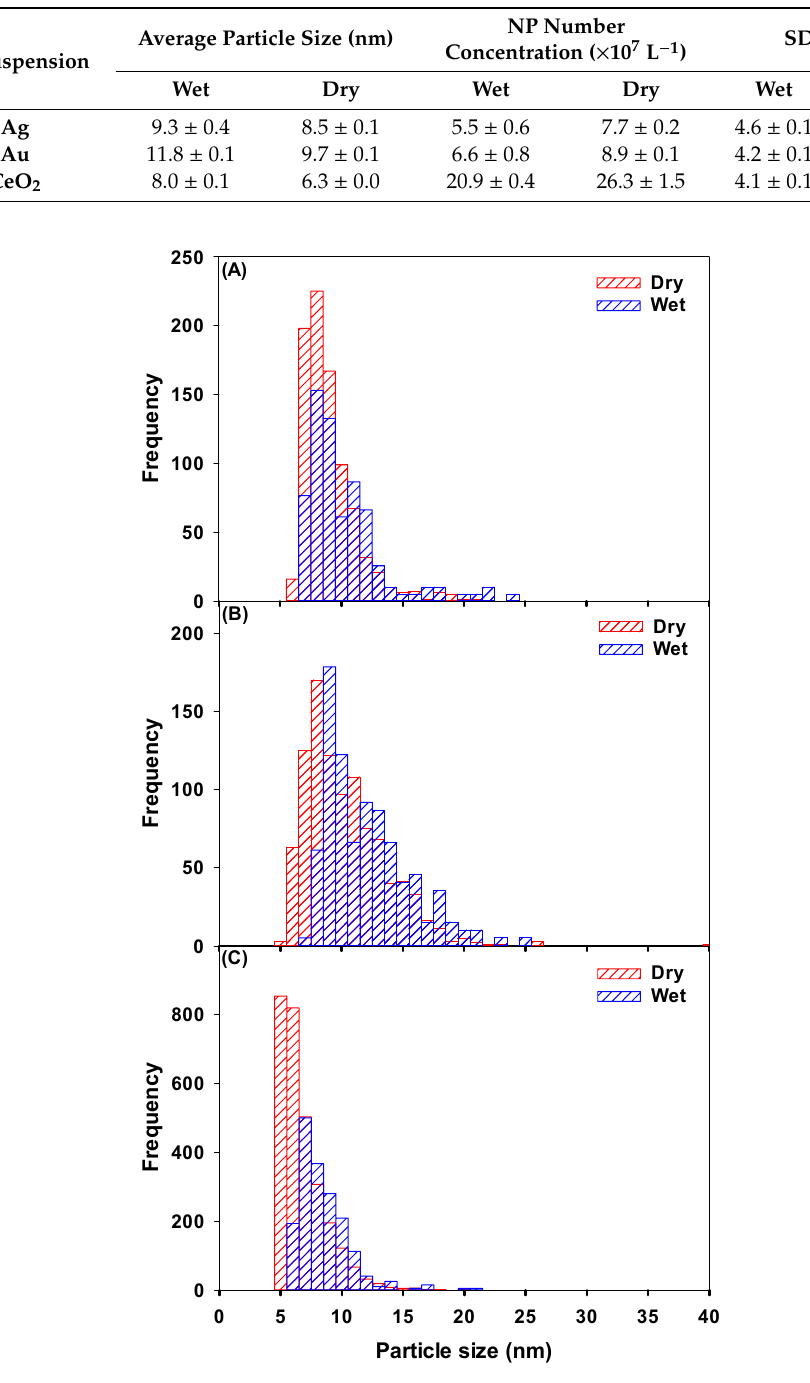
Figure 2. Particle size distributions as measured by wet-SF-ICP-MS (blue) and dry-SF-ICP-MS (red) for 3 suspensions of a small NP: ( A ) Ag: the mean particle size ± polydispersity of the suspension was 8.5 ± 2.2 with dry introduction and 9.8 ± 3.3 with wet introduction; ( B ) Au: the mean particle size ± polydispersity of the suspension was 9.8 ± 3.4 with dry introduction and 11.8 ± 3.6 with wet introduction; ( C ) CeO 2 : the mean particle size ± polydispersity of the distribution in the suspension was 6.3 ± 2.0 with dry introduction and 8.0 ± 2.1 with wet Table 2. Average particle sizes, number concentrations and SDL in 10 ng L − 1 suspensions of Ag, Au and CeO 2 NPs. Means and standard deviations are obtained from the analysis of triplicate samples. Average Particle Size (nm) NP Number Concentration (×10 7 L − 1 ) NP Suspension